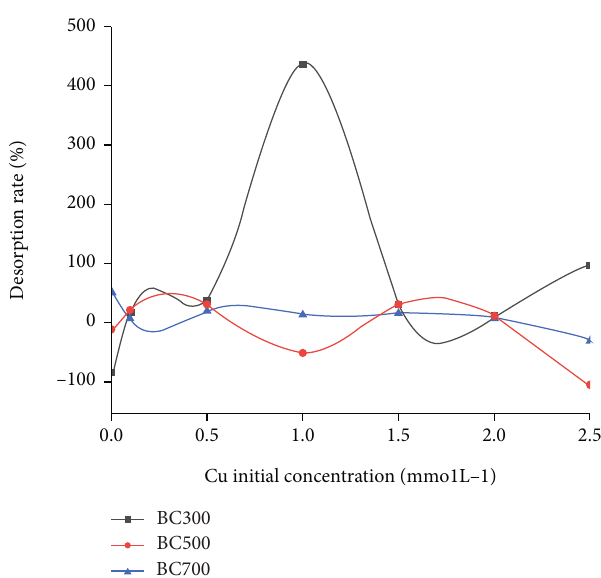
Figure 10: Desorption rate of Cu 2+ in straw with di ff erent concentrations of heavy metal ions in mixed working fl uid.